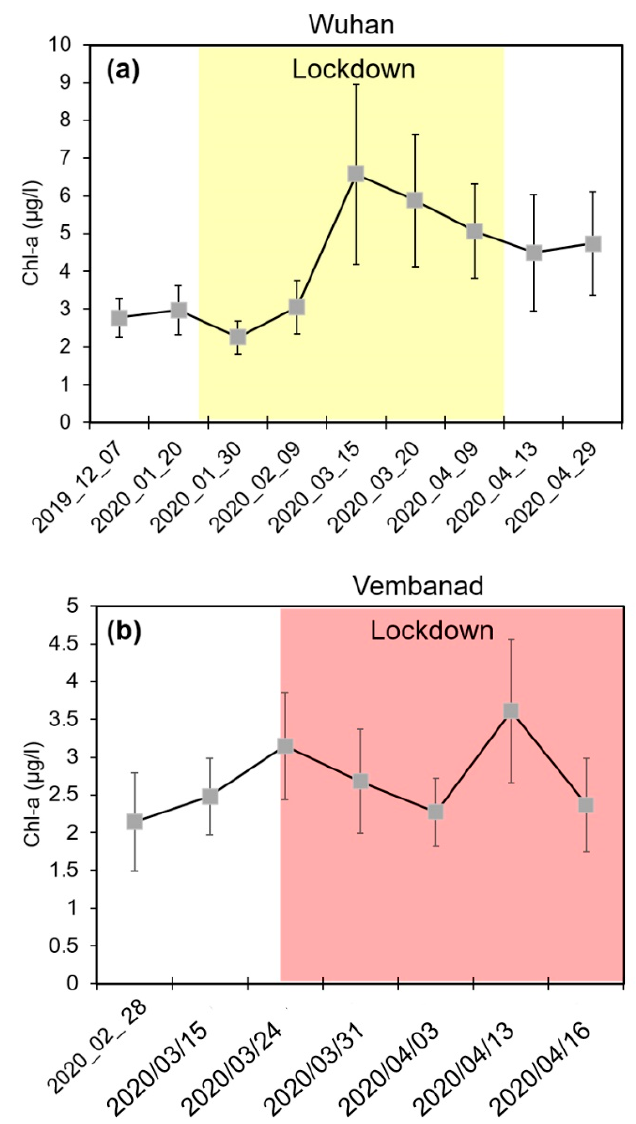
Figure 4. Mean chlorophyll- a during pre, during, and post lockdown in ( a ) Wuhan Lake and ( b ) Vembanad Lake (error bar shows ± standard deviations).